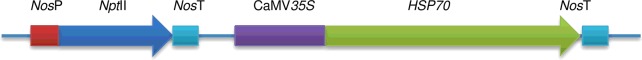
T-DNA of binary vector pJazz-HSP70 used for alfalfa transformation.